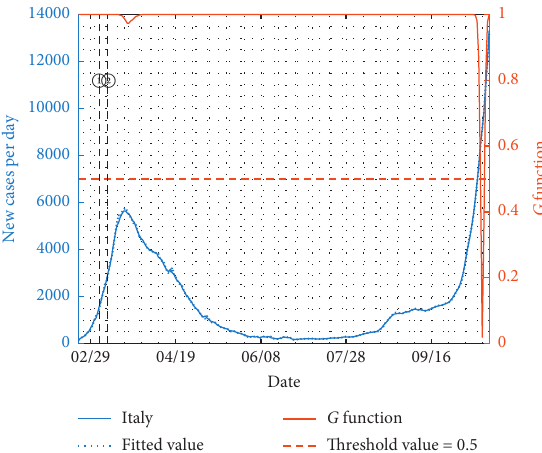
Figure 19: The fitting result of Italy containing the second wave. The left axis shows the daily confirmed cases for the real data after smoothness (blue solid line) and its fitted values by the STAR model (blue dashed line). The right axis shows the value of non- linear functions G changing with time (orange solid line) and the reference line with threshold 0.5 (orange dashed line). The vertical dotted line indicates the sequential released policies: ① close schools across the country and ② nationwide lockdown.